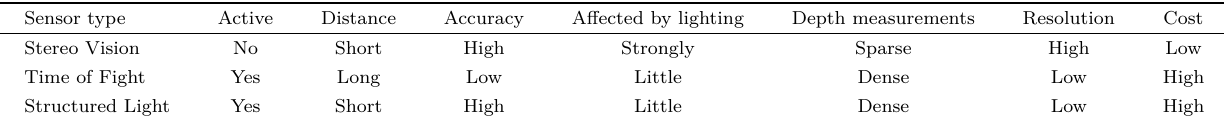
Table 1 Comparison of three types of depth